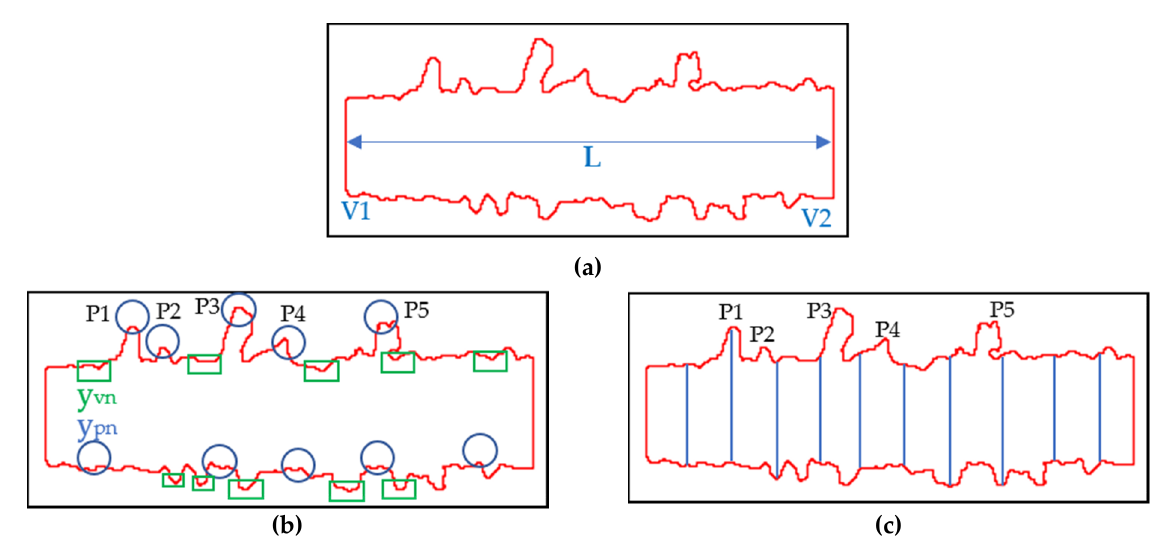
Figure 4. Examples of: the ROI perimeter index ( a ); the ROI roughness index ( b ); the ROI width STD index ( c )